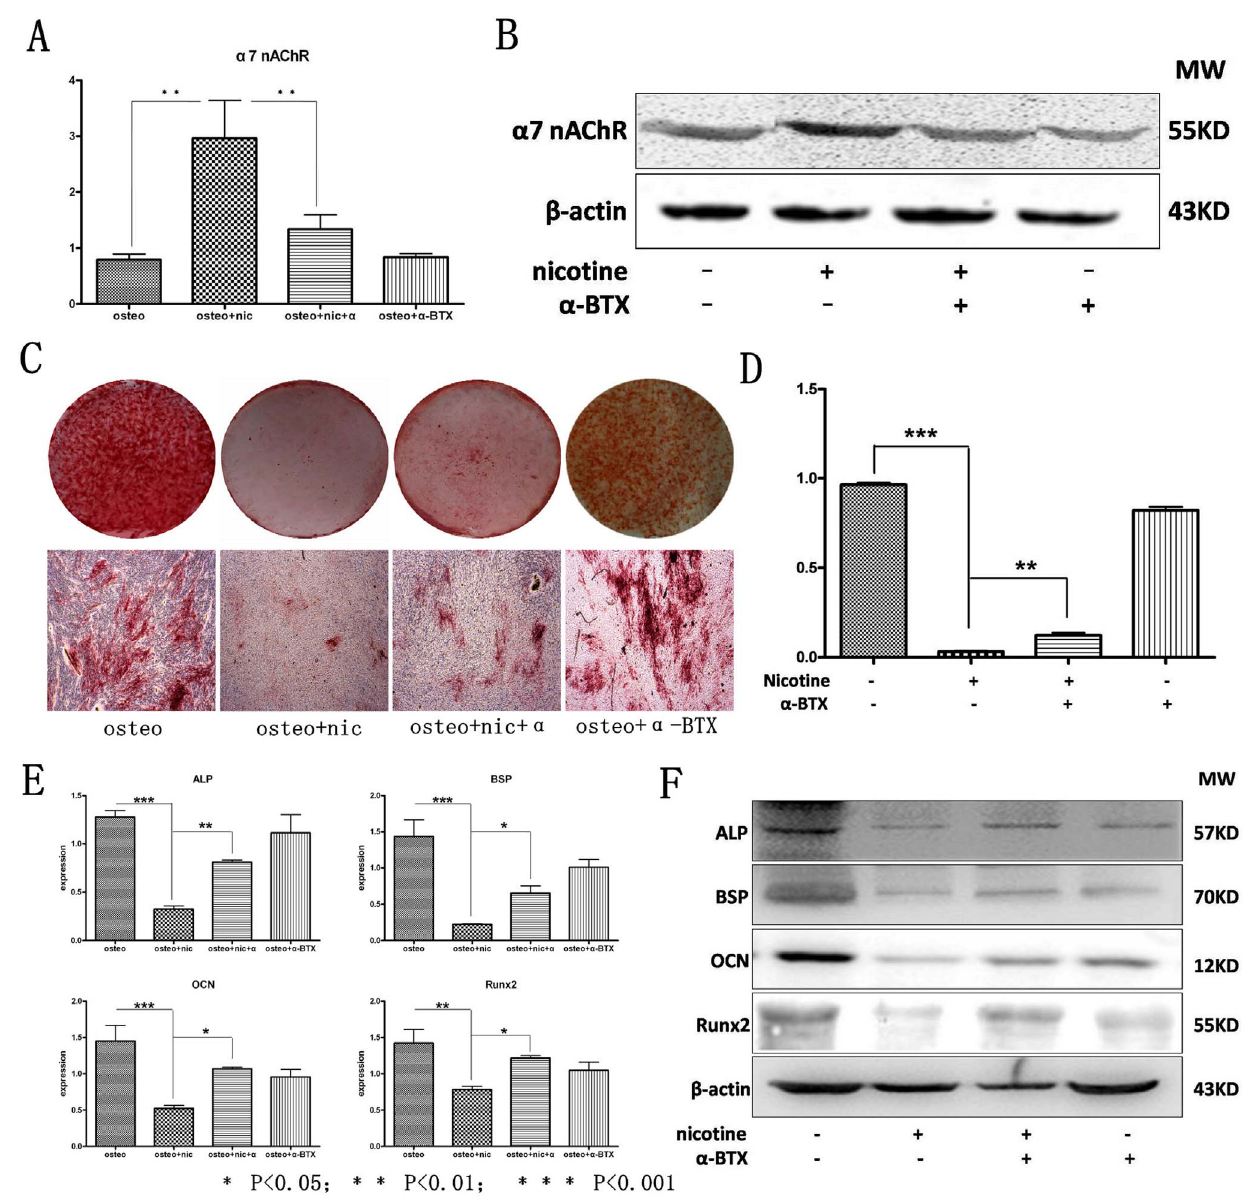
Figure 4. Nicotine deteriorates the osteogenic differentiation of hPDLSCs through the activation of a 7 nAChR. The expression of a 7 nAChR in PDLSCs from each group was detected by ( A ) qRT-PCR and ( B ) Western Blot analysis. C, D : hPDLSCs treated with/without nicotine and a - BTX were cultured in osteogenic medium and osteogenic differentiation was determined by Alizarin red S staining after 21 days. E : The expression of osteogenic related genes Runx2, BSP, ALP and OCN were determined by qRT-PCR after 14 days of culturing with osteogenic supplement. F : The expression of osteogenic related protein Runx2, BSP, ALP and OCN were determined by western blot after 14 days of culturing with osteogenic supplement. Data represent the means 6 SD. *p , 0.05 (n=3). alone didn’t enhance the expression of these genes and proteins Results of Alizarin Red S staining (Figure 5B, C) revealed that (Figure 5D, E). the down regulating effect of nicotine toward the osteogenic differentiation of hPDLSCs was reversed when treated by dkk1 while dkk1 treatment alone had no effect in up regulating the osteogenic differentiation of hPDLSCs. Expression of osteogenic genes and proteins were in accordance with the histological staining. Nicotine suppressed the expression of ALP, OCN, BSP and Runx2 in gene and protein levels while this effect was partially reversed when dkk1 was added simultaneously with nicotine in the osteogenic induction medium. Results also indicated that dkk1